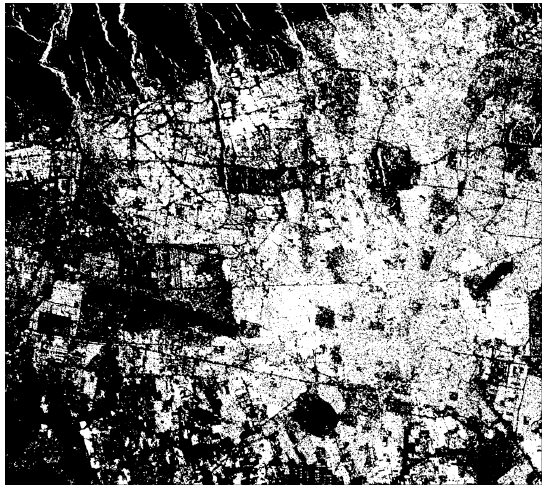
Figure 3. Classification of polarimetric bands of ALOS/PALSAR image (White: impervious surfaces, Black: non-impervious surfaces)